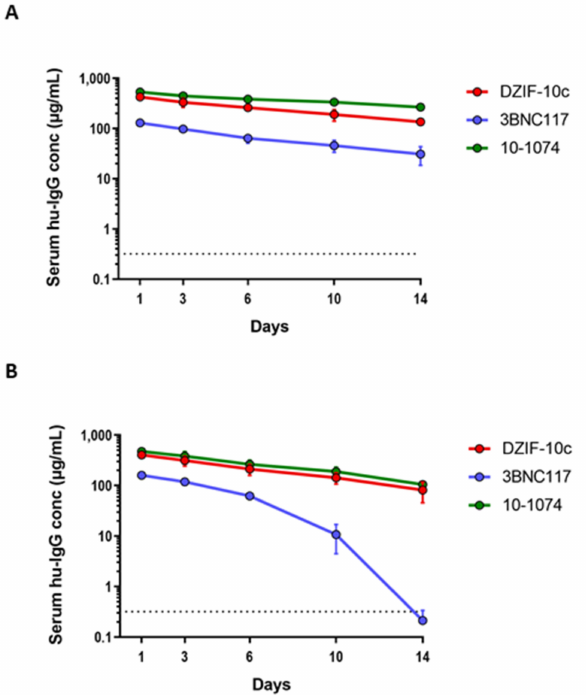
Figure 3. DZIF-10c shows a favorable pharmacokinetic profile in huFcRn and NRG mice. ( A ) Phar- macokinetic profile of DZIF-10c and two human anti-HIV-1 IgG1 antibodies in mice expressing the human neonatal Fc receptor after i.v. injection of a 0.5 mg dose. ( B ) The pharmacokinetic profile of DZIF-10c and two human anti-HIV-1 IgG1 antibodies in NRG mice after i.v. injection of a 0.5 mg dose. Antibody levels were determined by human IgG-specific ELISA. N = 4 per group and antibody. Symbols show means, error bars indicate standard